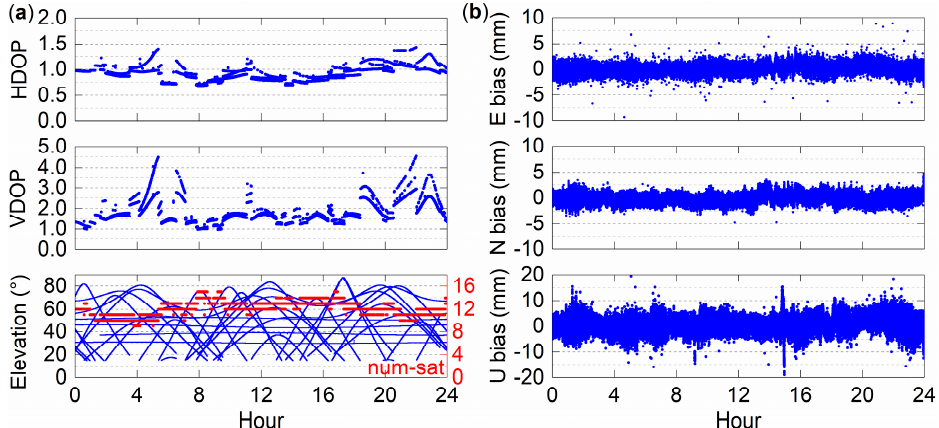
Figure 10. ( a ) HDOP, VDOP, and elevation of DOY303; and ( b ) the corrected series by the SD- MHM in the east, north, and vertical directions.